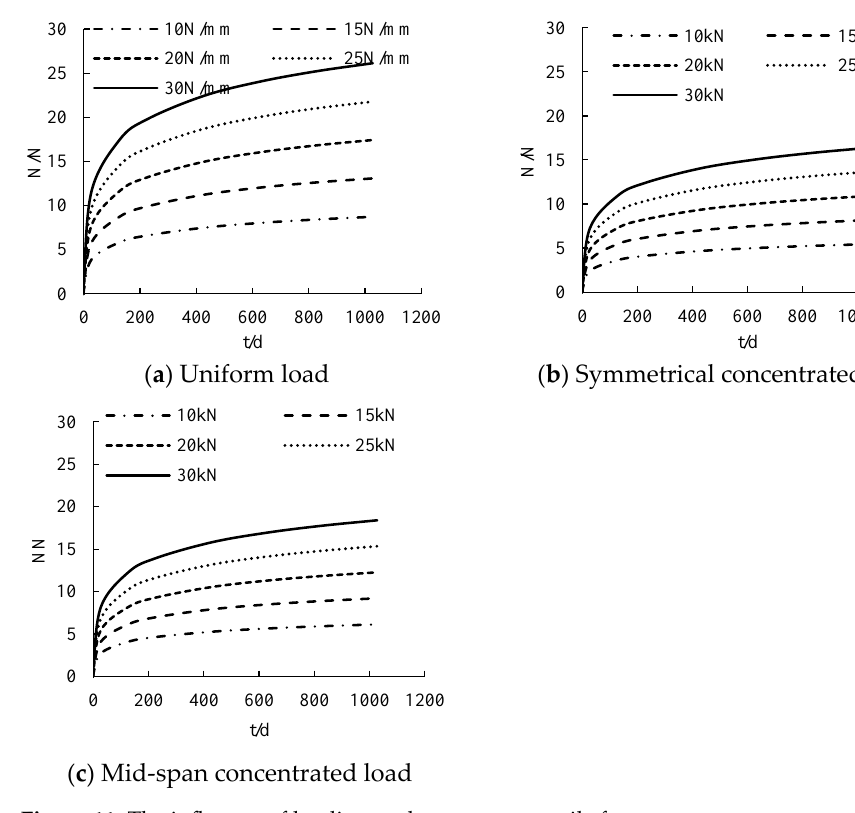
Figure 11. The influence of loading under creep on tensile force.